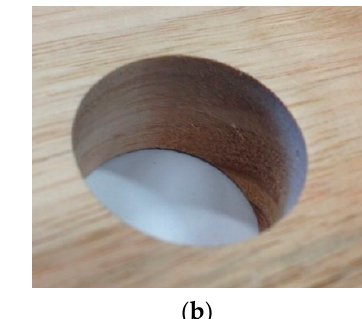
(good) ( b ) for boring tear-out. Figure 9. Examples of E. nitens with a grade of G0 (excellent) ( a ) and E. globulus with a grade of G2